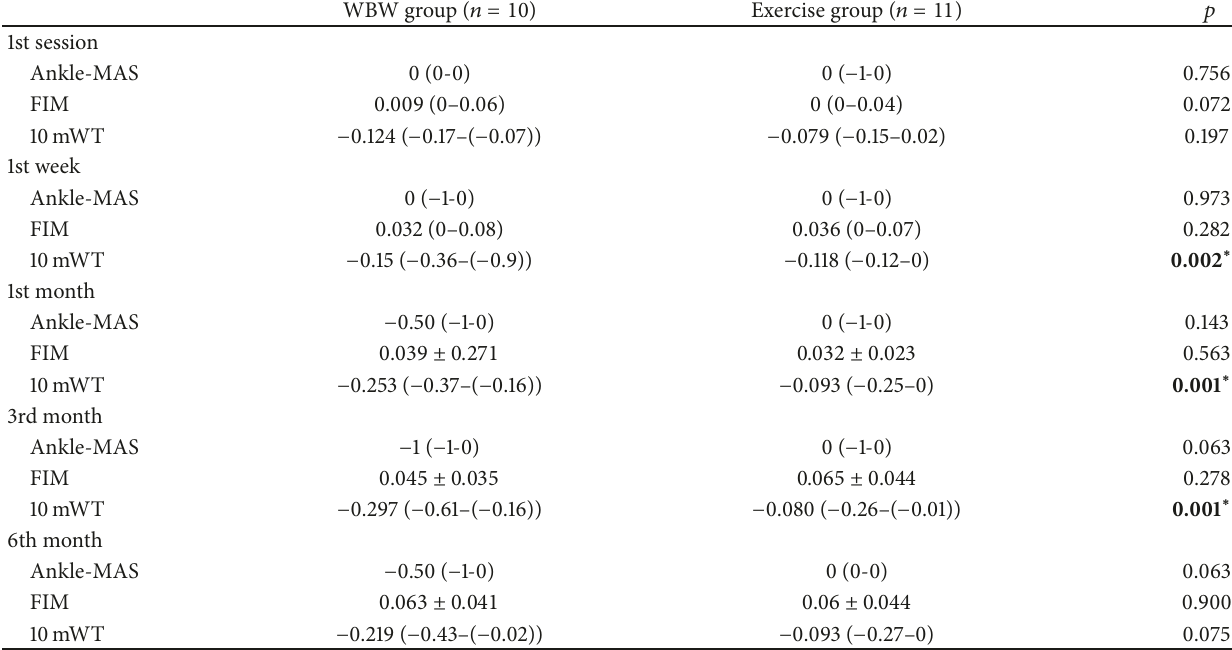
Table 2: Statistical significance of the percent of changes and difference scores from baseline and group comparisons for these variables.